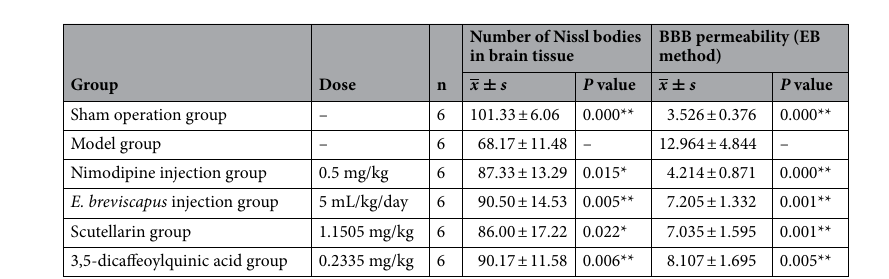
Table 4. Number of Nissl bodies in brain tissue and BBB